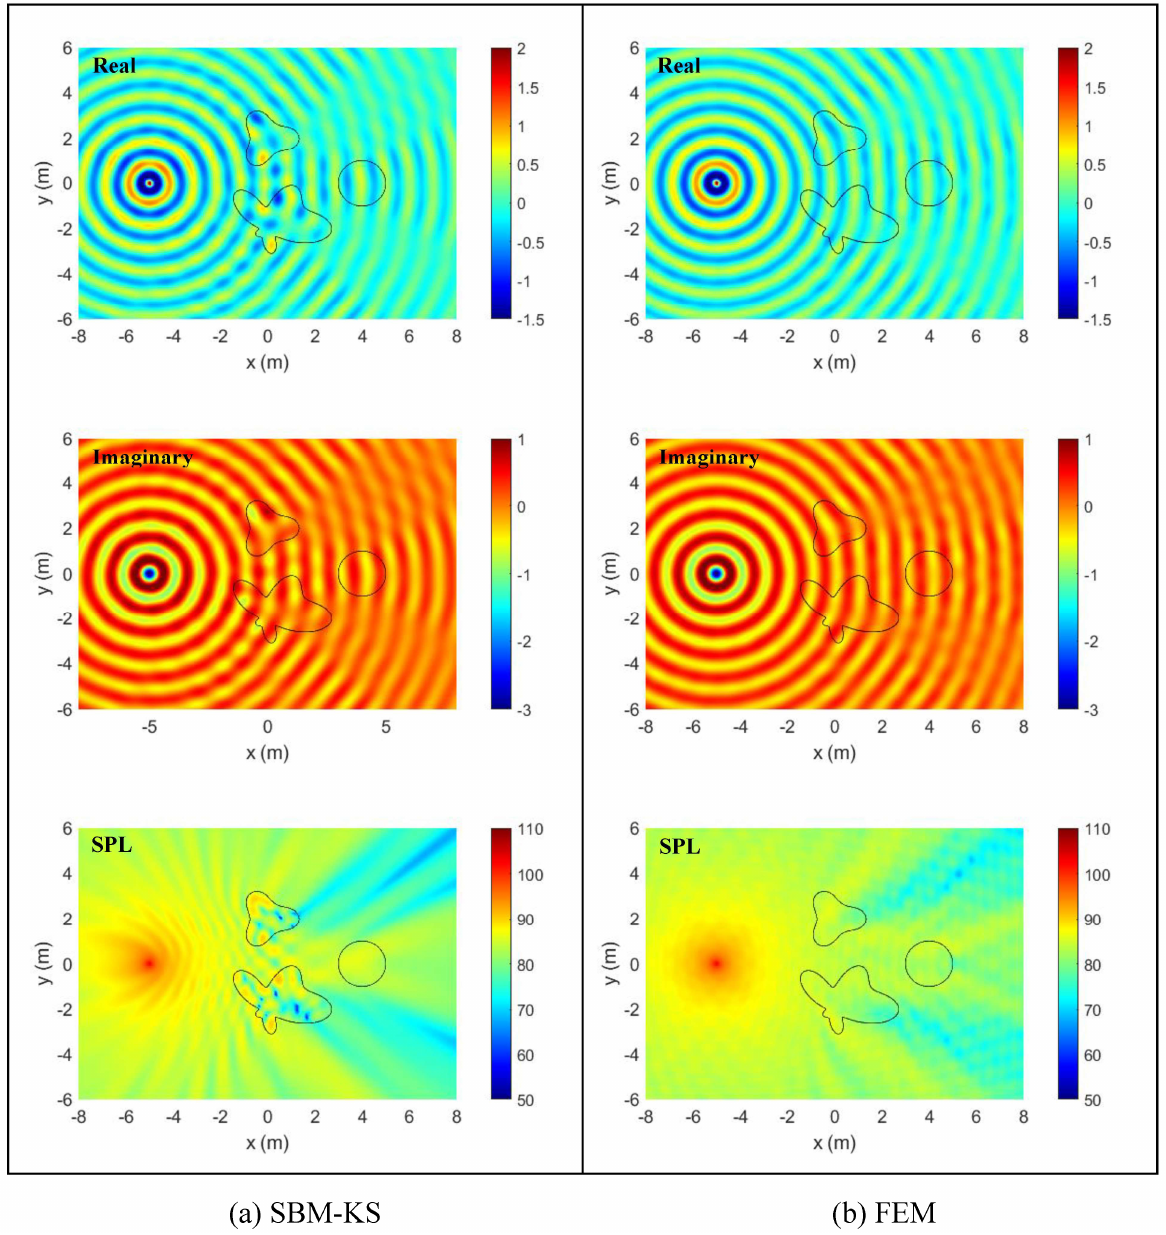
Figure 14. Profiles of sound pressure and sound pressure level obtained using the SBM–KS approach and COMSOL FEM at a frequency of 1500 Hz.